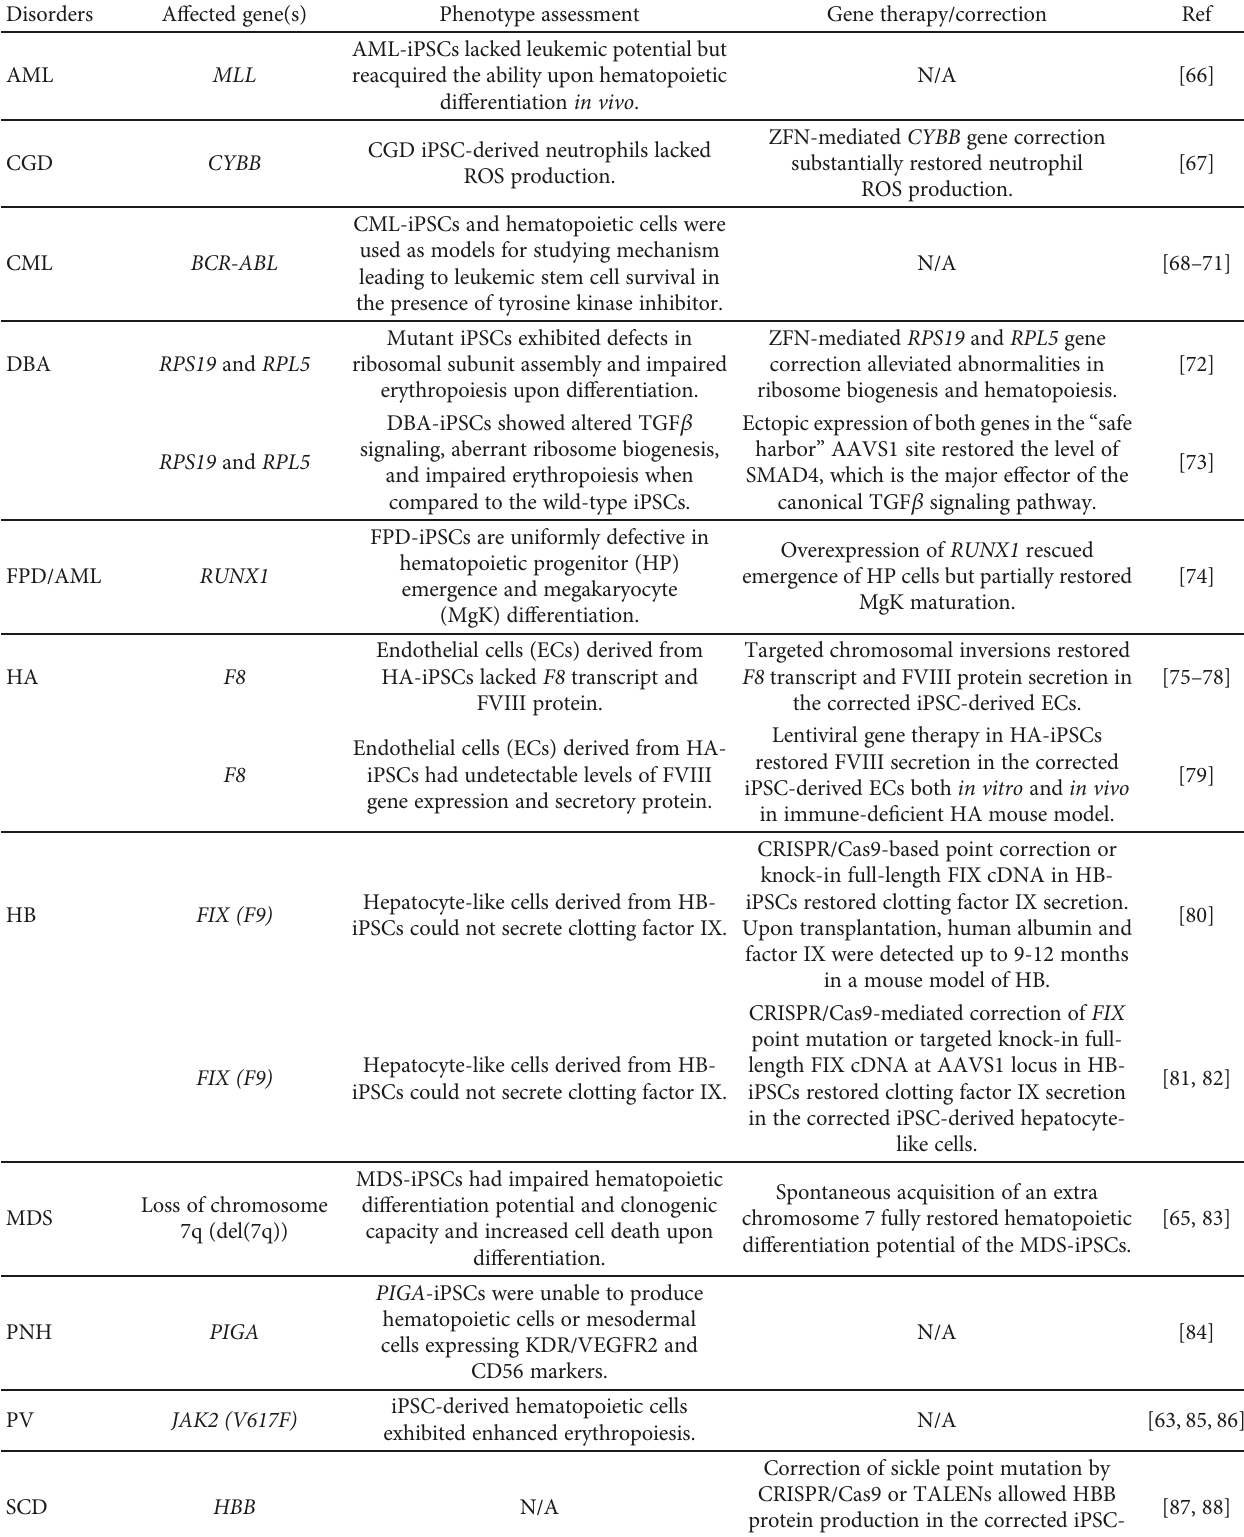
Table 1: iPSCs as disease models and applications of gene therapy or genome editing for hematological disorders.